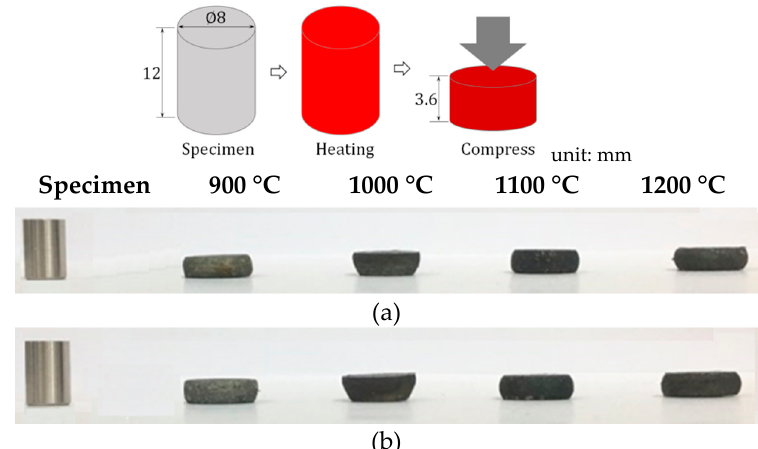
Figure 3. Shapes of specimens after high-temperature compression: ( a ) 10 s − 1 strain rate, ( b ) 30 s − 1 strain rate.